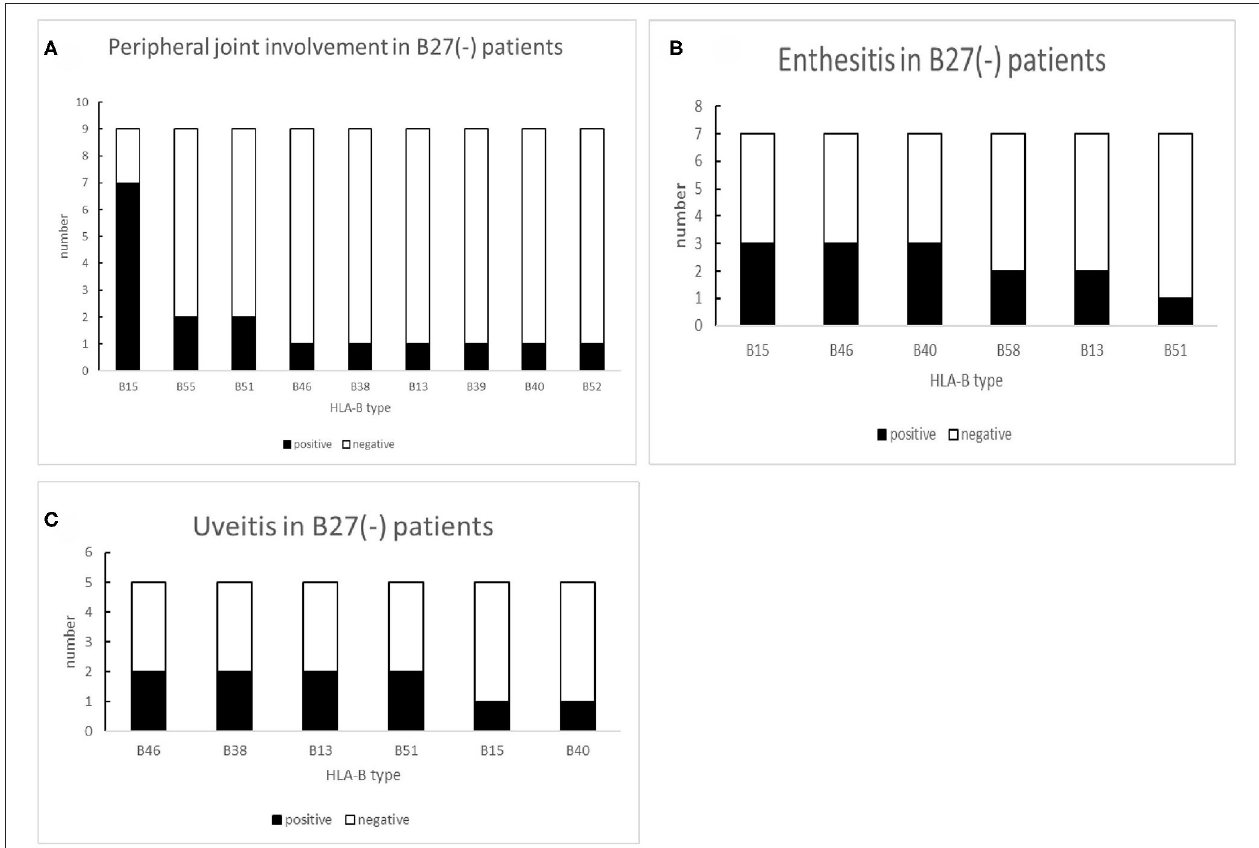
FIGURE 6 | The number of other HLA-B types shown in B27( − ) patients with different peripheral manifestations: (A) number of other HLA-B types shown in B27( − ) patients with peripheral joint involvement, (B) number of other HLA-B types shown in B27( − ) patients with uveitis, and (C) number of other HLA-B types shown in B27( − ) patients with